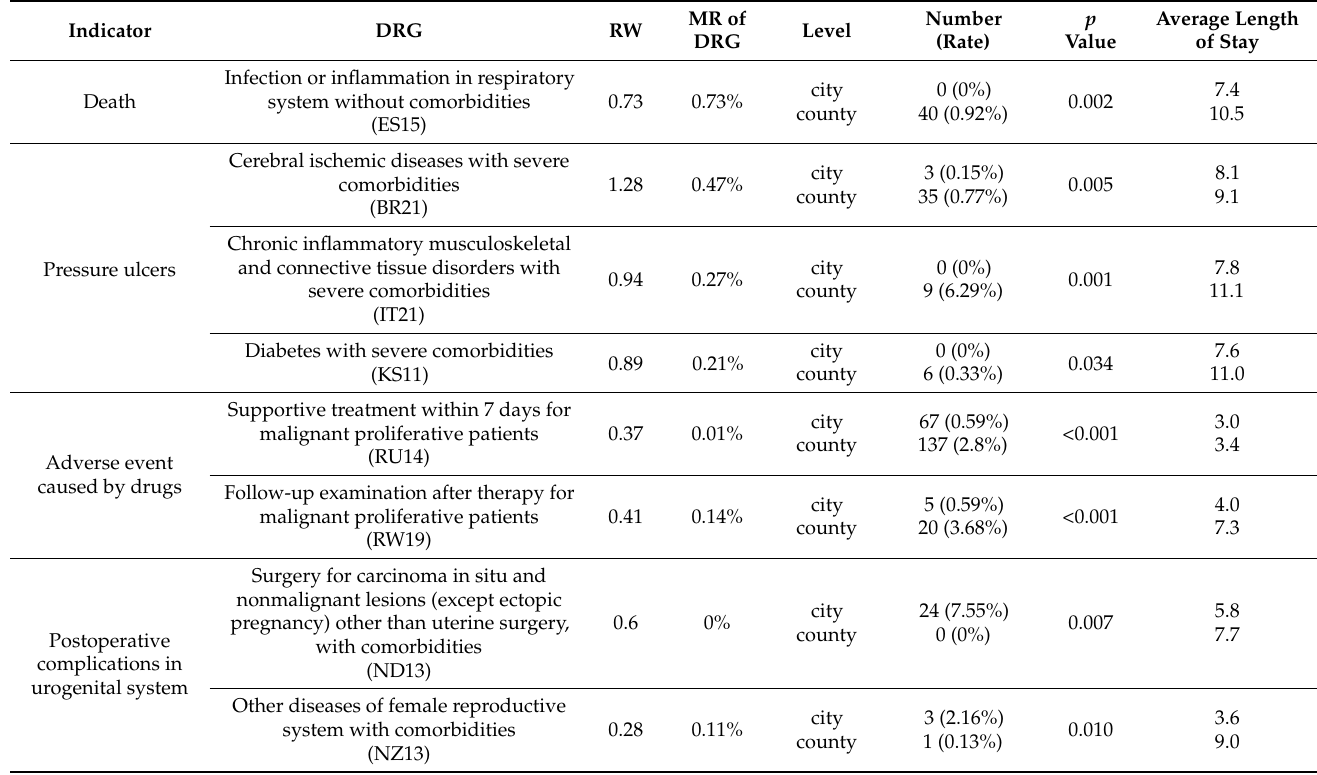
Table 4. The significant differences in the quality level between the two